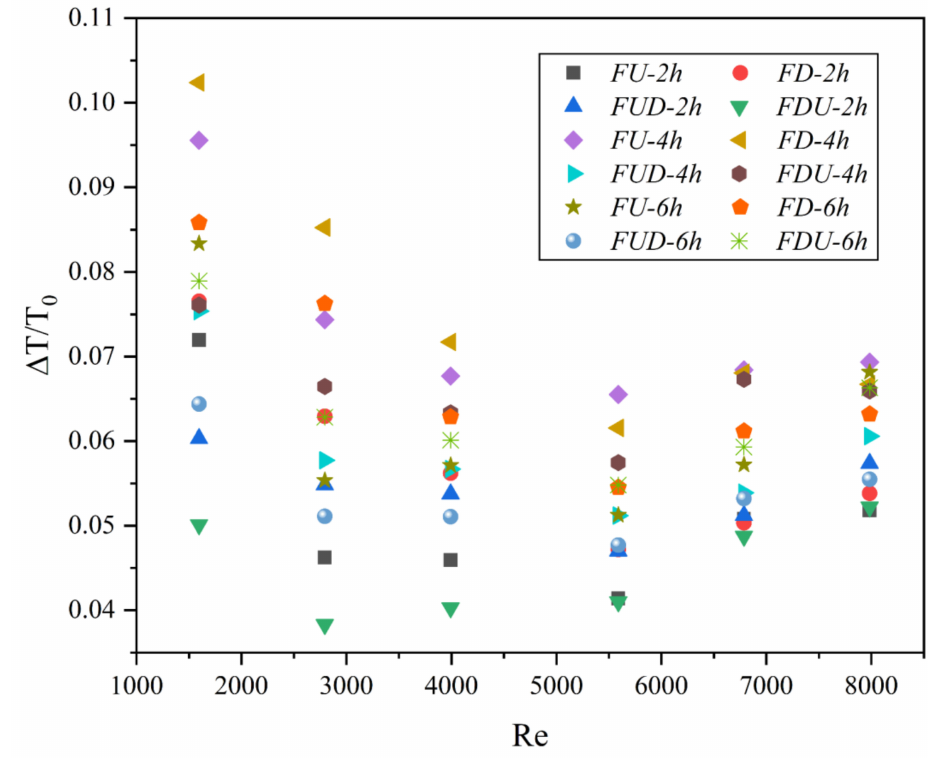
Figure 8. Performance of thermal enhancement factor ∆ T